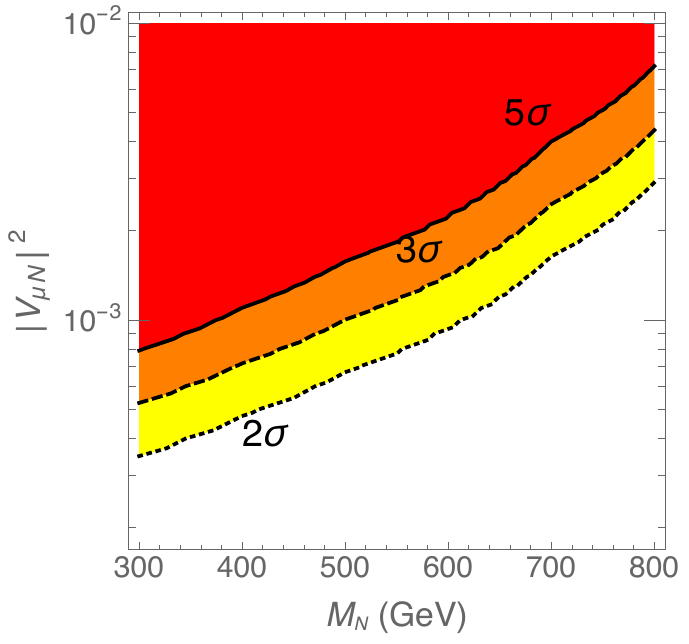
2 at the 13 TeV V (cid:22)N j j